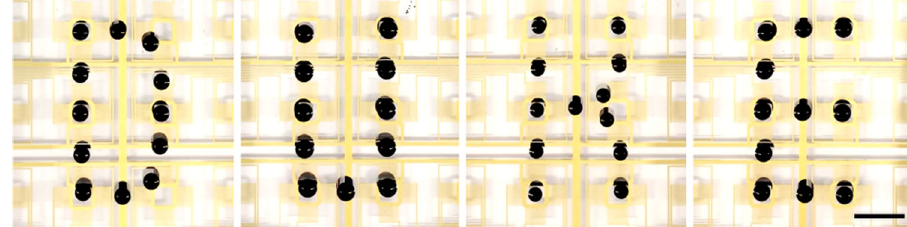
Fig. 5 Programmable single-droplet transport via digital acousto fl uidics. The hydrodynamic traps are activated following a pre-programmed movement sequence, resulting in the digital hydroacoustic formation of the letters ‘ DUKE ’ . Each pixel consists of four independent IDTs; therefore, each droplet can be transported dynamically in any direction on the x – y -plane using a trap-and-release mechanism using an off-chip electromechanical relay controller. Scale